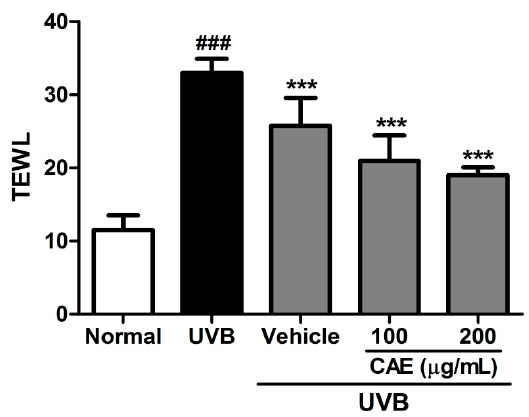
Figure 12. Effects of CAE on TEWL in chronic UVB-irradiated hairless mice. Significant difference versus control: ###, p < 0.001; significant difference versus the UVB-induced group: ***, p < 0.001.